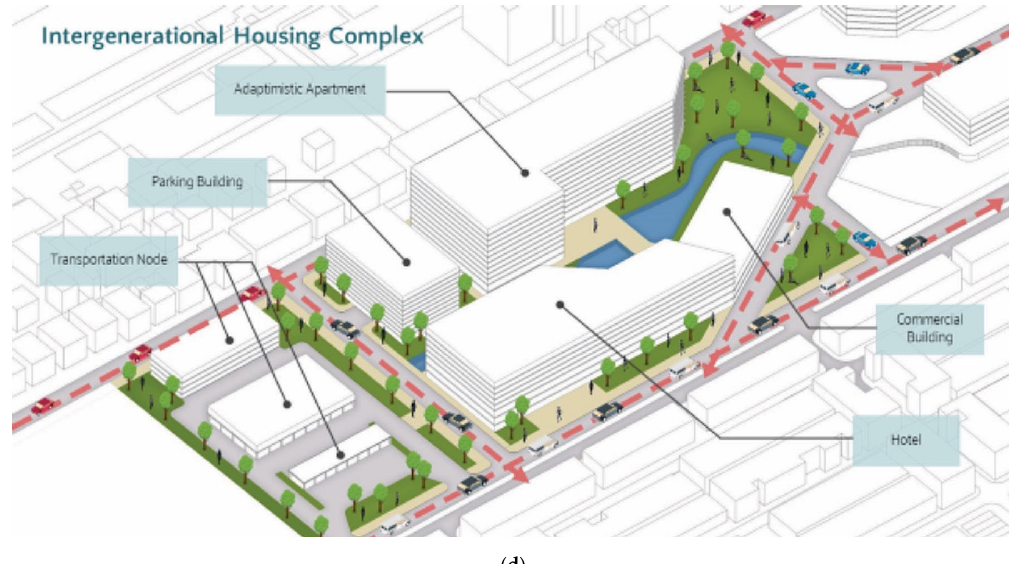
Figure 10. ( a ) Neighborhood scale master plan for the Digital-Village area (outlined in red). Graphics